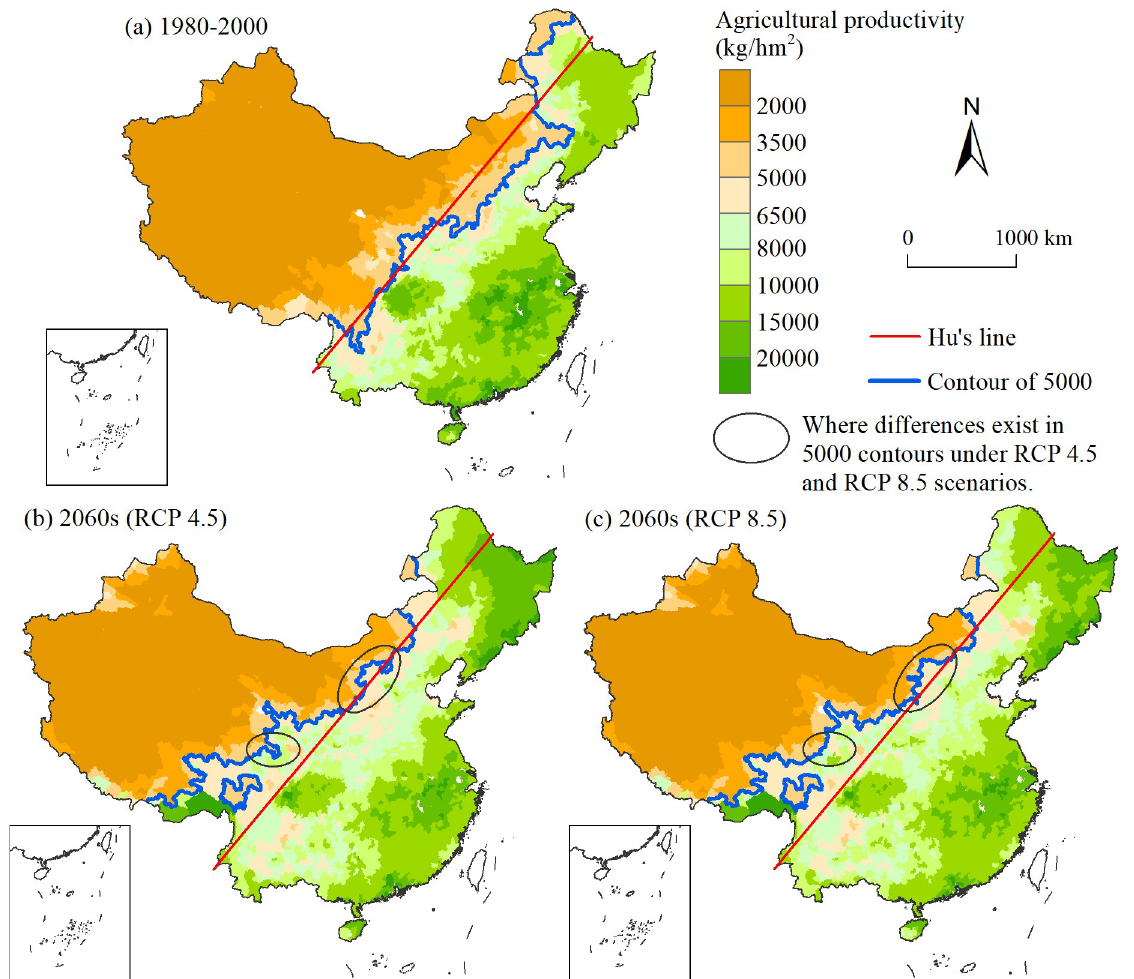
Fig 10. Maps of potential agricultural